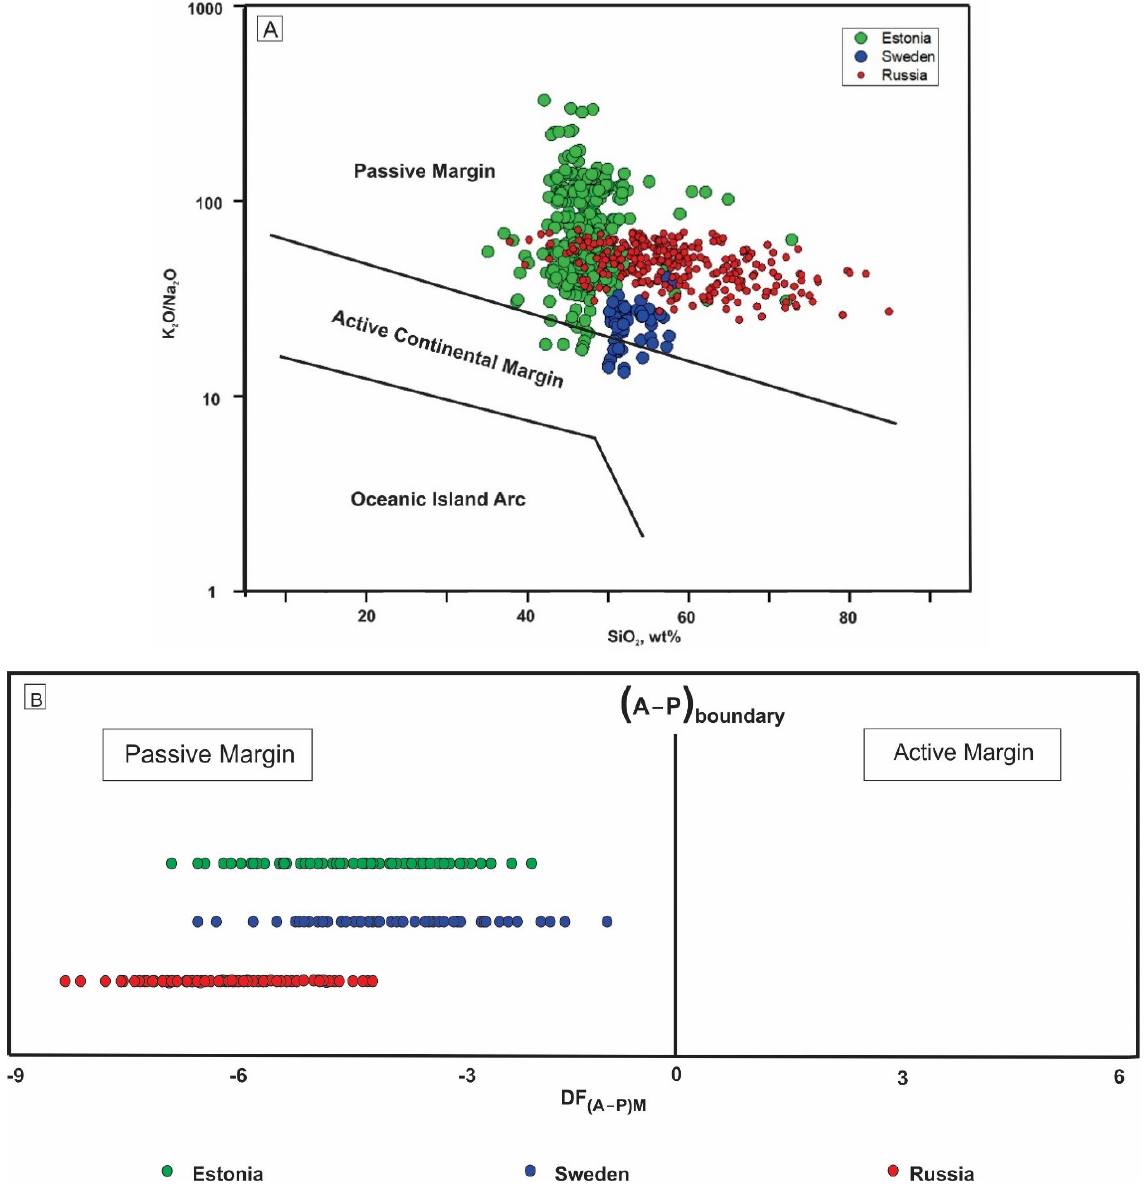
Figure 5. Tectonic setting discrimination plot for the studied black shales: ( A ) K 2 O/Na 2 O versus SiO 2 [3]; ( B ) major element-based active and passive margin setting discrimination model [7]. The black vertical line in figure ( B ) represents the boundary between active margin (right) and passive margin (left) fields. For steps to calculate DF (A − P)M , see [7].